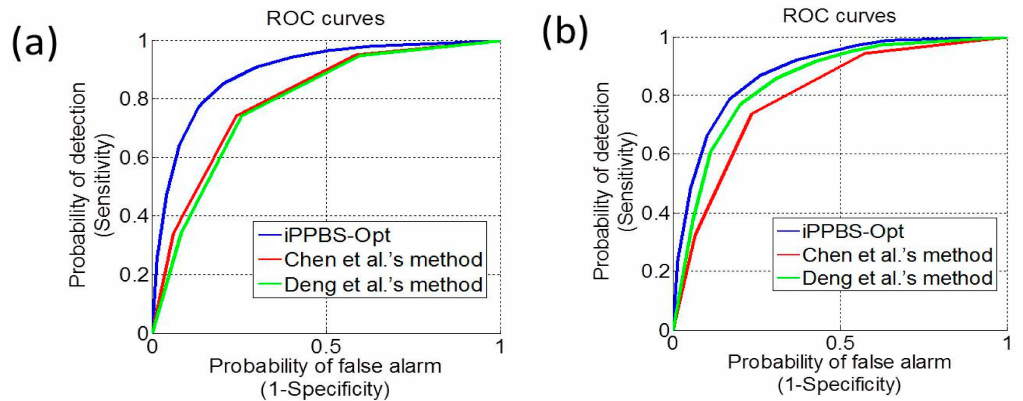
Figure 5. The ROC (Receiver Operating Characteristic) curves to show the 10-fold cross validation by iPPBS-Opt , Deng et al. ’s method [10], and Chen et al. ’s method [11] on ( a ) surface-residue benchmark dataset; and ( b ) the all-residue benchmark dataset. As shown on the figure, the area under the ROC curve for iPPBS-Opt is obviously larger than those of their counterparts, indicating a clear improvement of the new predictor in comparison with the existing Figure 1. The proposed framework inspired by HVS. Figure 1. The proposed framework inspired by HVS.